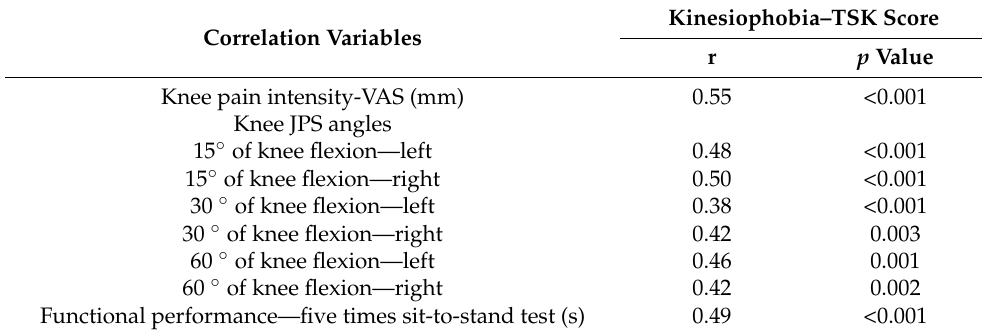
Table 2. Association between kinesiophobia, pain intensity, functional performance, and propriocep- tion ( n =